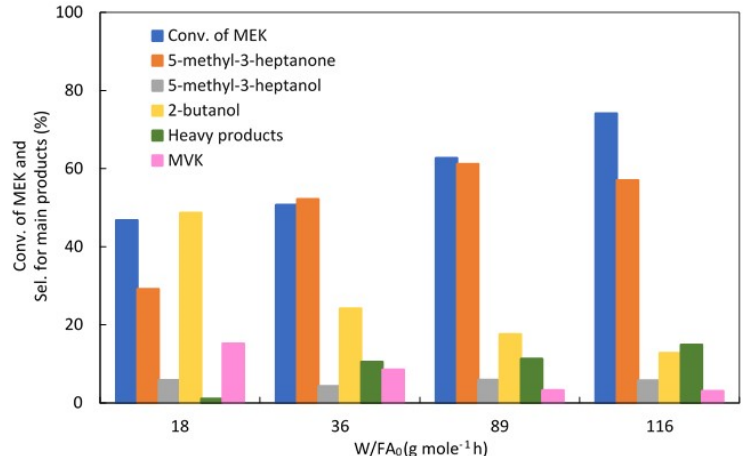
Figure 6. Catalytic results for the conversion of MEK to products with different space times after 1 h of the reaction. Reaction conditions: catalyst weight, 1.0 g (15 wt % Cu–ZrO 2 ); feed rate of MEK, 1.0 mL/h; H 2 /MEK molar ratio, 2; reaction temperature, 180 ◦ C. Heavy products include C 12 ketone, C 12 alcohol, condensation products, and so on.